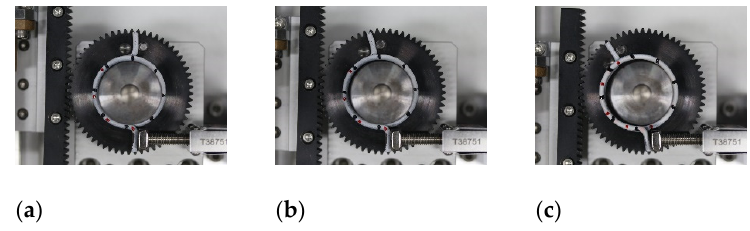
Figure 6. Measurement of x- and y-coordinates of torsion springs: ( a ) 0°; ( b ) 20°; ( c ) 40°.